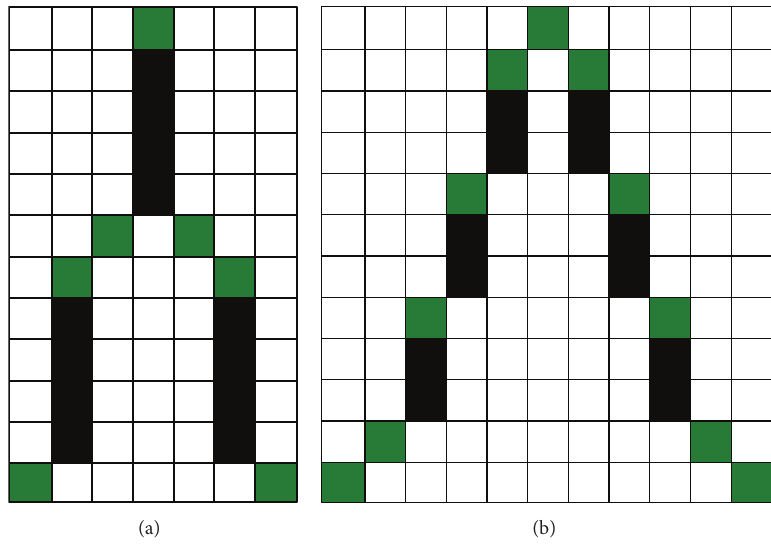
Figure 7: (a) Basic function for radius 2 ; (b) basic function for radius 4 .